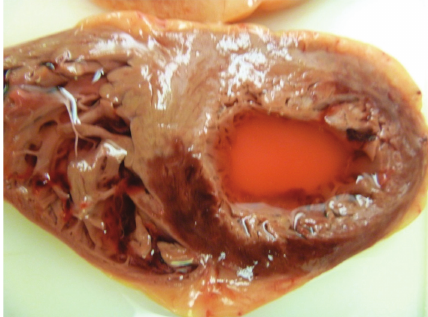
Figure 4: Postmortem photographs illustrating a large anterolateral myocardial